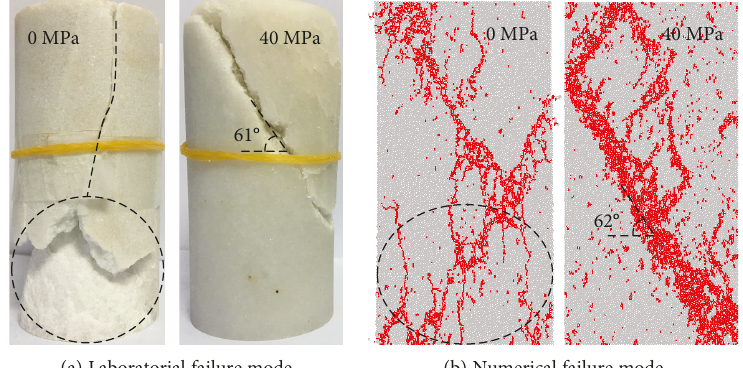
Figure 6: Laboratorial and numerical failure modes of marble specimens under compression (the red short lines in numerical specimens represent microcracks).